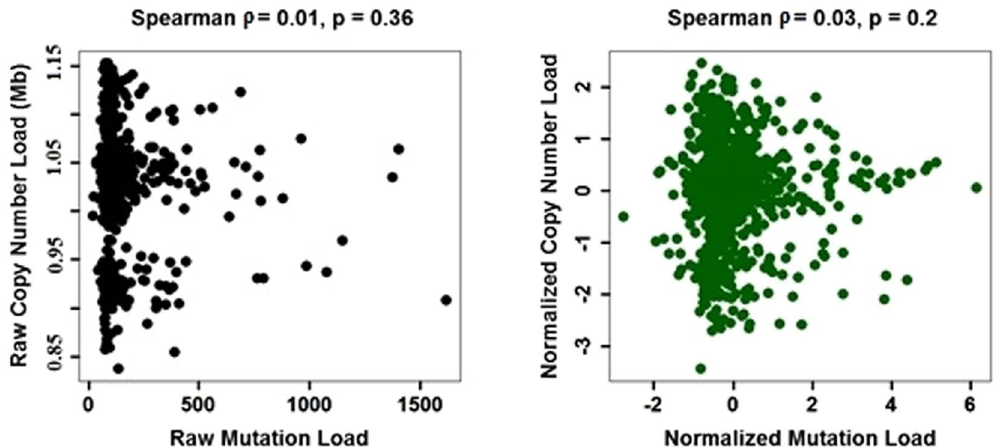
Figure 2. Correlation between copy number and point mutation loads. Copy number and point mutation measures of genetic load are uncorrelated. We combined all cell lines in the data set for this analysis. The left panel shows raw measures of load, while the right panel shows measures that were z-score normalized within each tissue type (i.e. divide by the the standard deviation after subtracting the